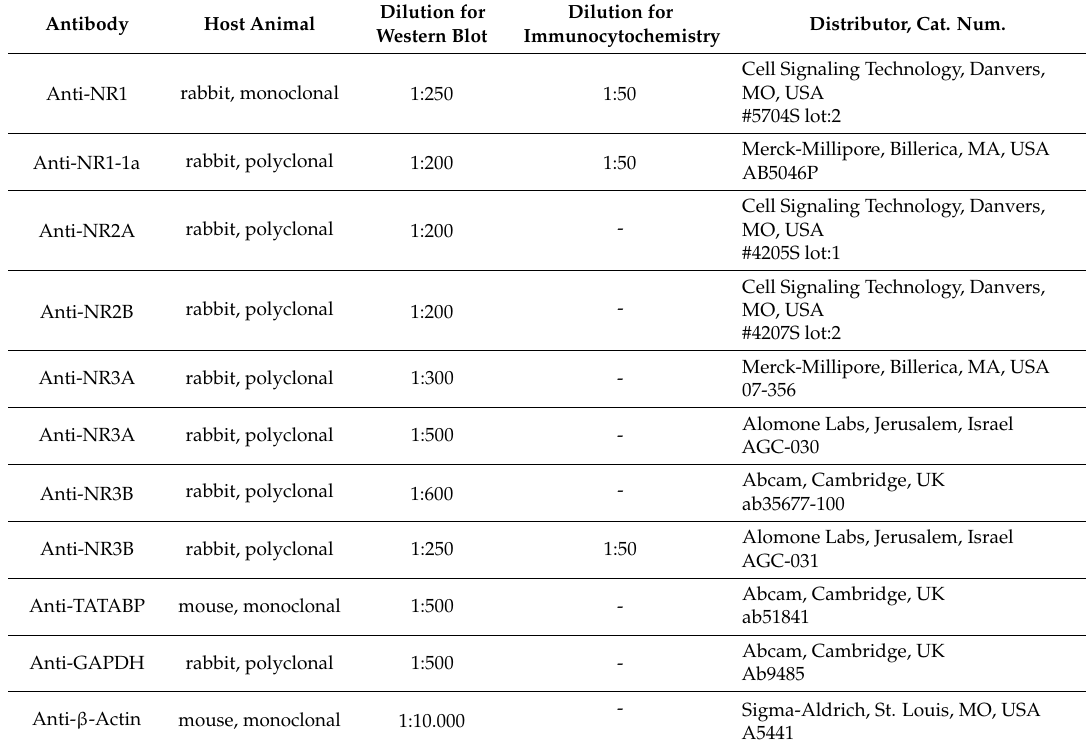
Table 2. Tables of antibodies used in the